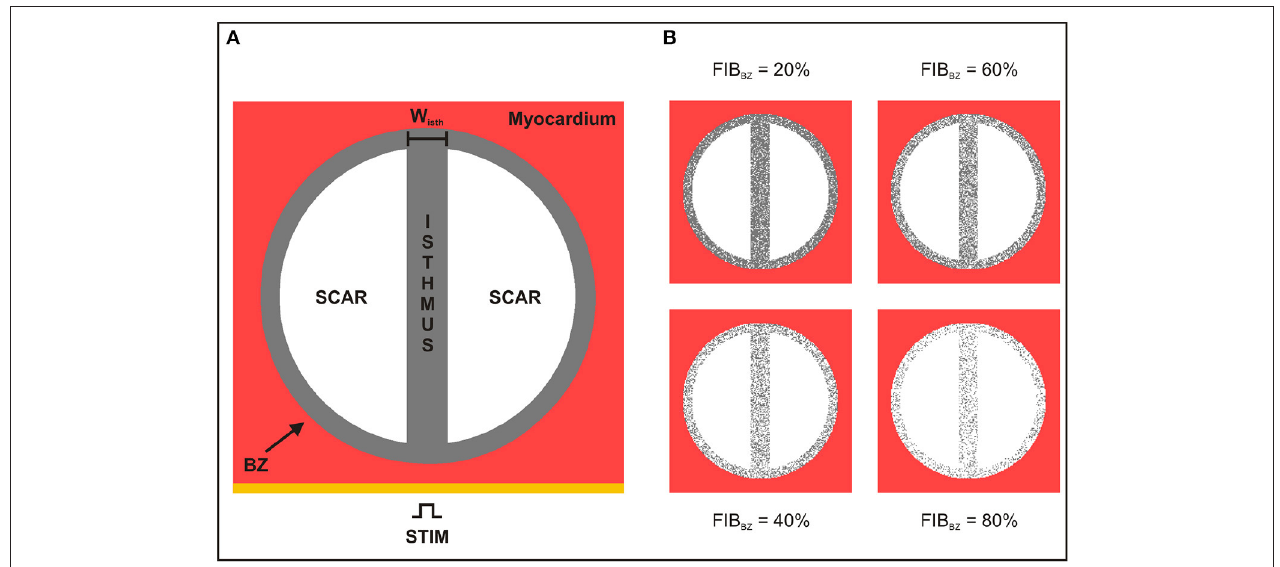
FIGURE 2 | Schematic of the 2D sheet computational model. (A) The idealized infarct consisting of a circular region representing the BZ (gray), which contains two circular segments representing the scar (white), is surrounded by healthy myocardium (red). The BZ region contains an isthmus of width w isth separating the scars.